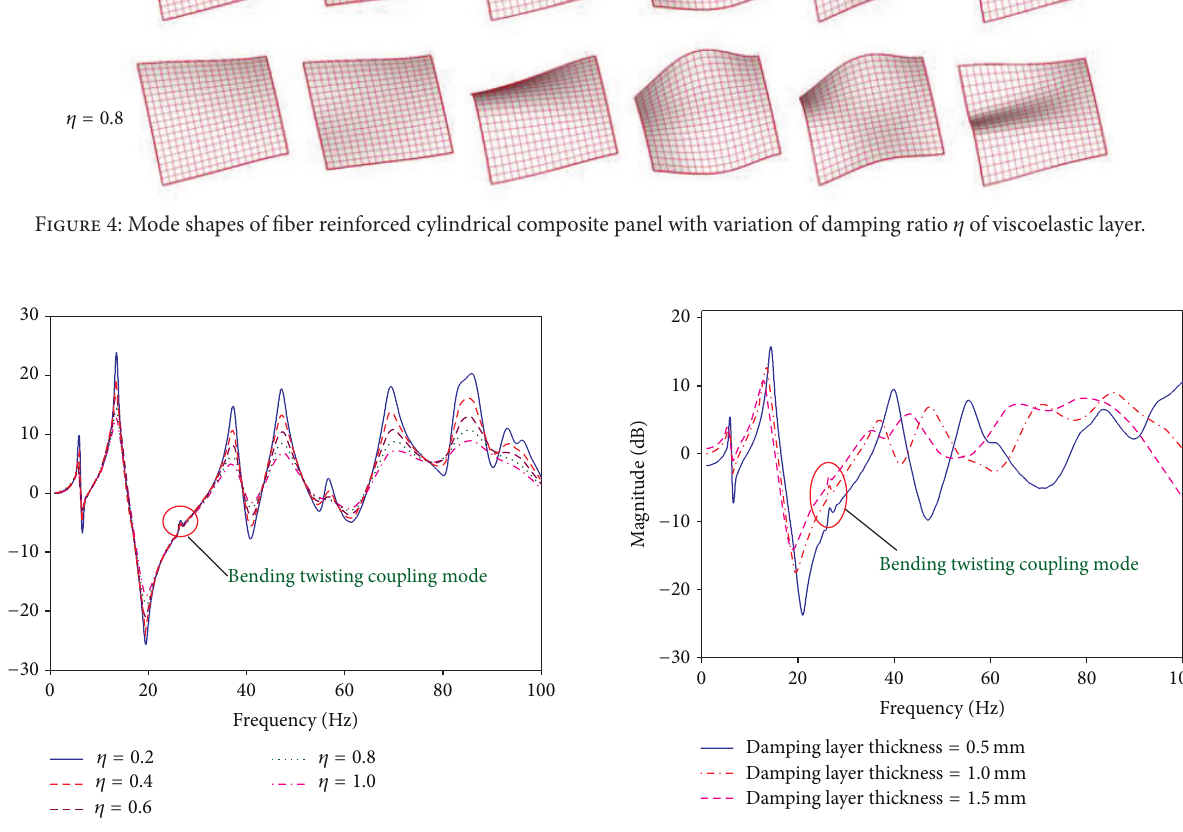
Figure 5: Frequency response functions of fiber reinforced compos- ite wind blade with variation of damping ratio 𝜂 of viscoelastic layer ( 𝑇 V = 1 mm).